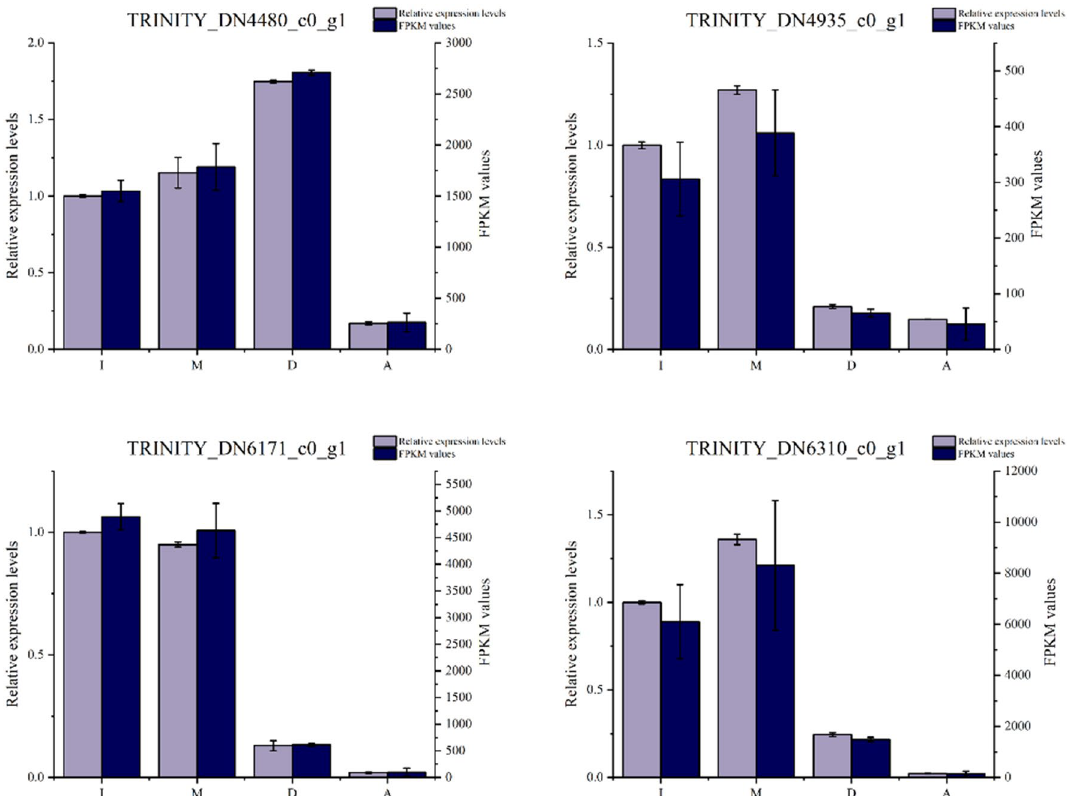
Figure 9. Comparison of qRT-PCR analysis of gene expression with RNA-seq data in stages I, M, D, and A of fruiting body development in C. comatus. The Y axis shows the relative Mrna expression